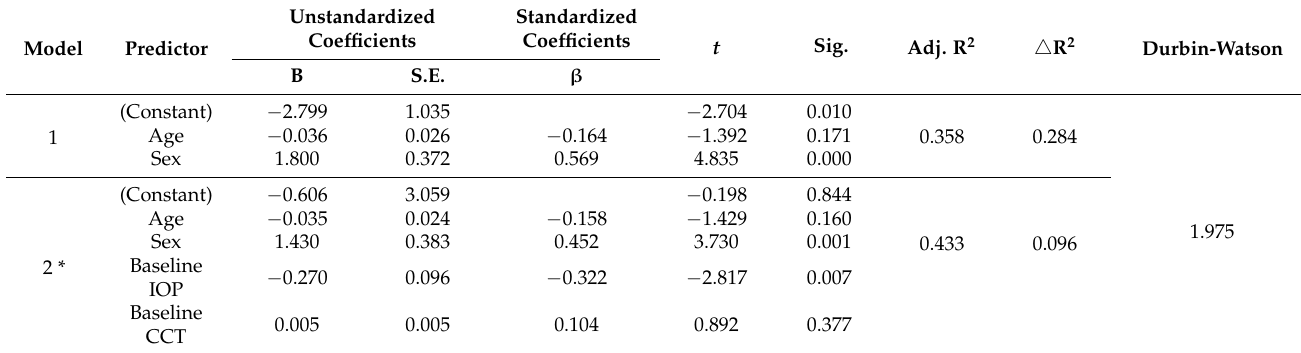
Table 6. Regression